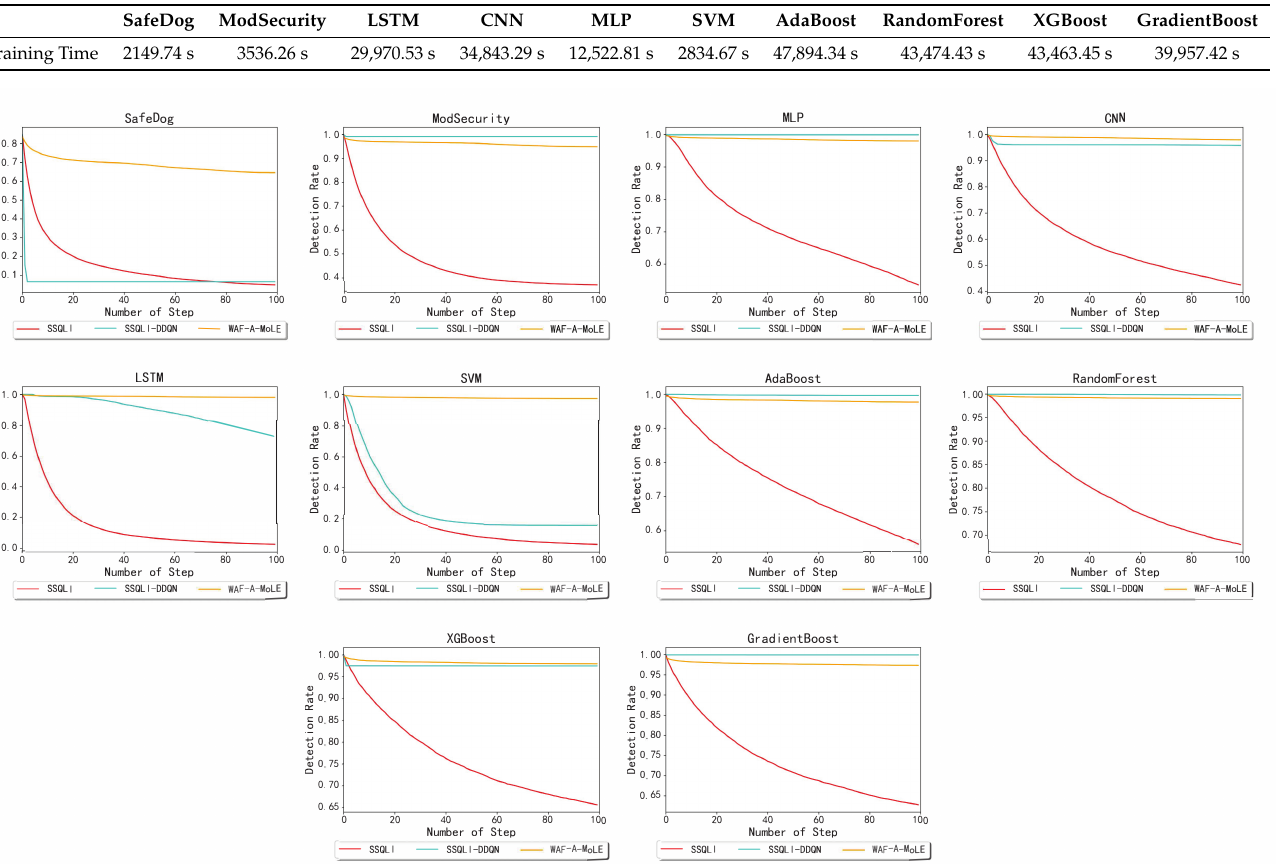
Table 10. Time consumption of SSQLi.